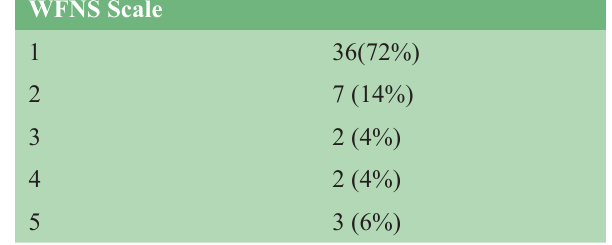
Table 3. WFNS Scale of SAH